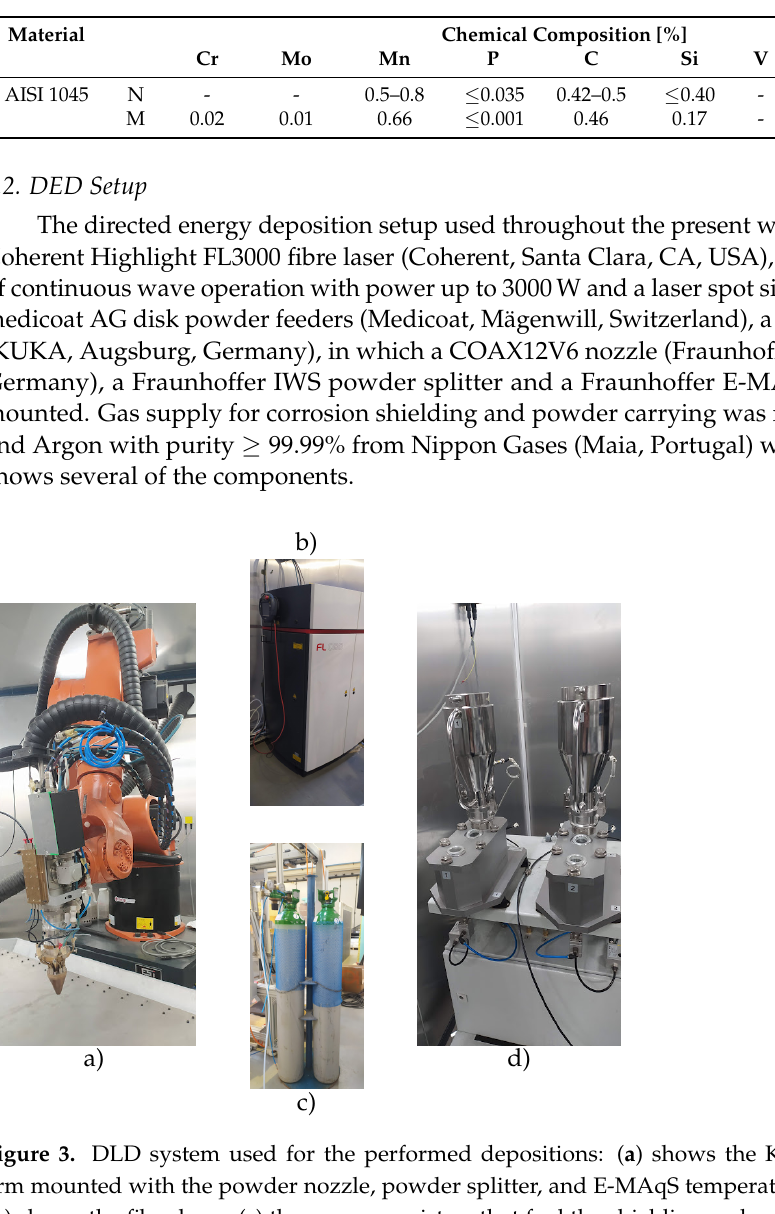
Table 1. Nominal (N) and measured (M) chemical composition of AISI 1045, used as the substrate in the performed depositions.